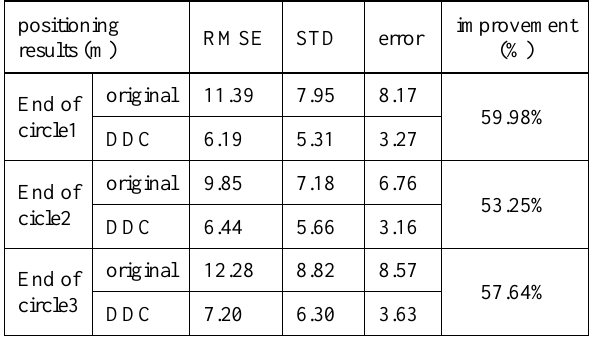
Table 1. The error of BLE positioning result of participant 1